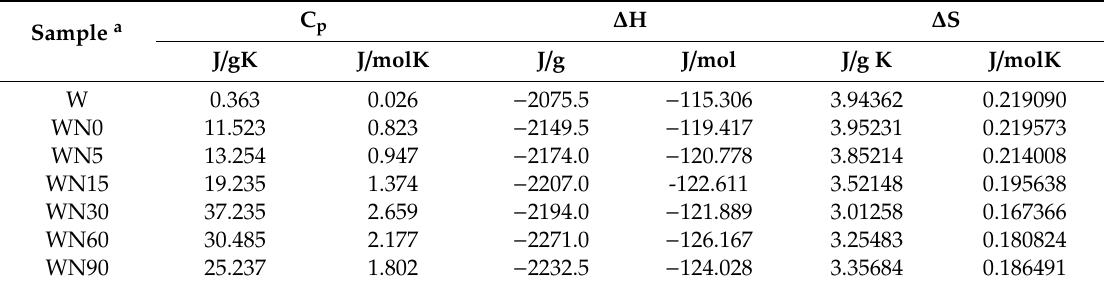
Table 4. Thermodynamic data for treated with GP deionized water saturated with nitrogen.